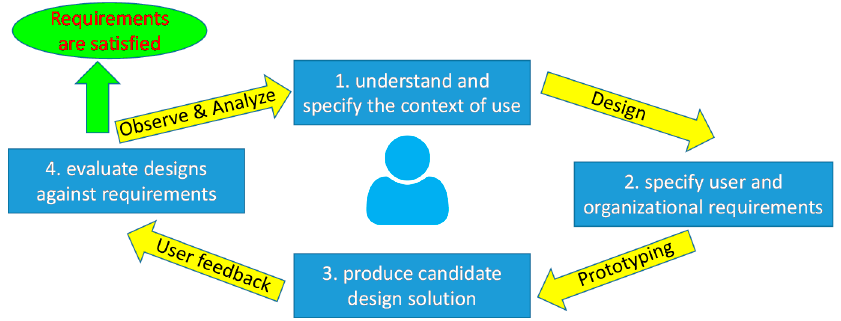
Figure 1. HCD activities.